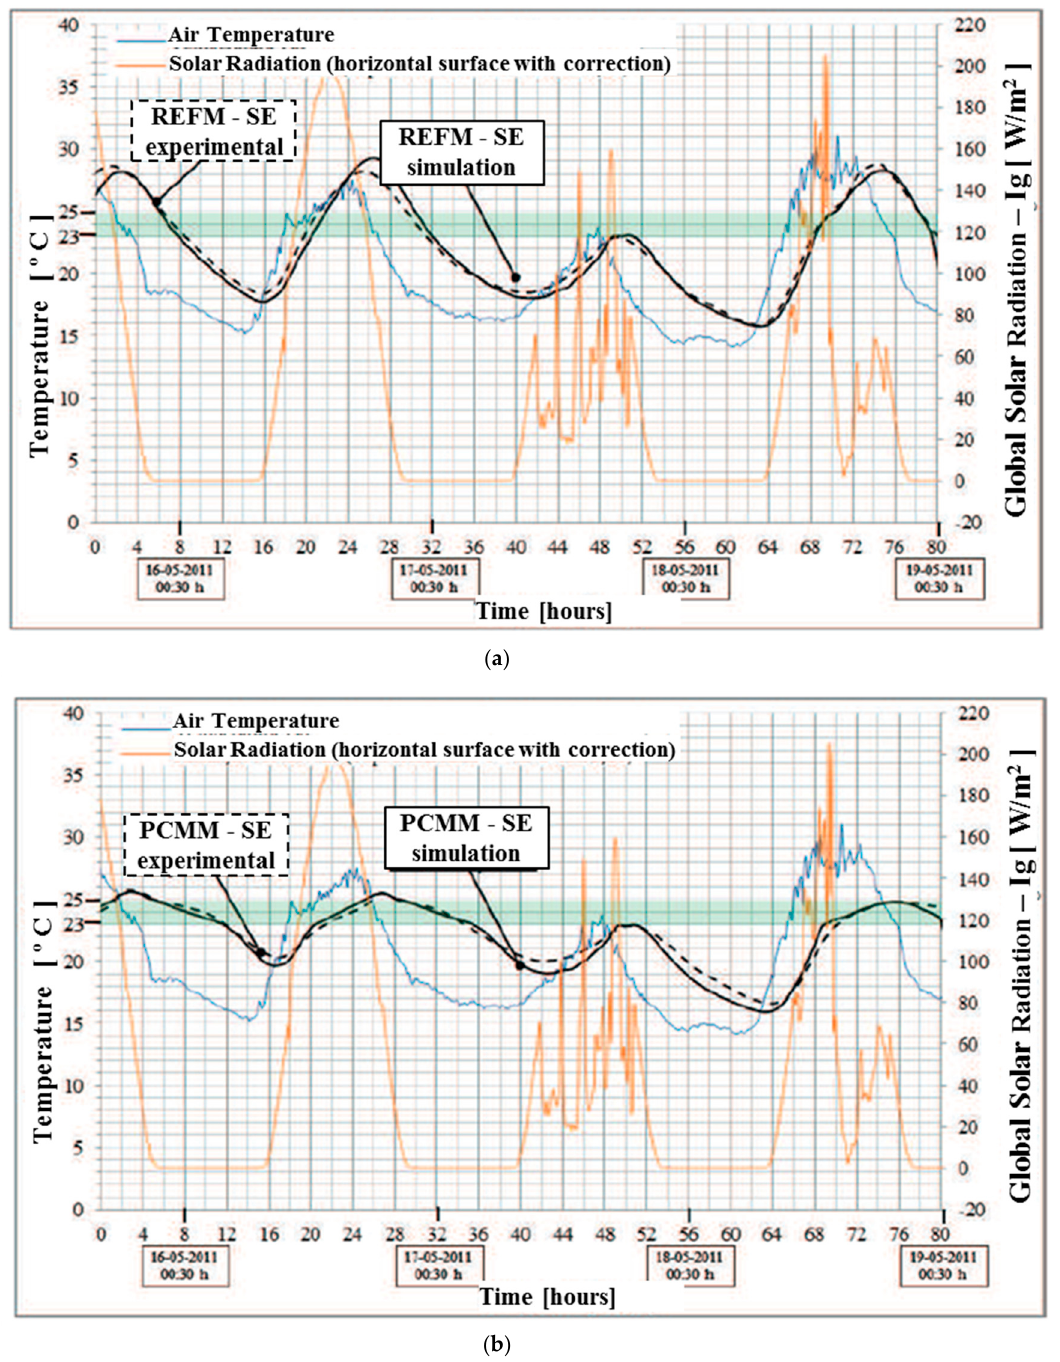
Figure 16. In situ monitoring and numerical simulation of the temperatures in the cover of ( a ) PCMM test cell and ( b ) REFM test cell, between 15th and 19th